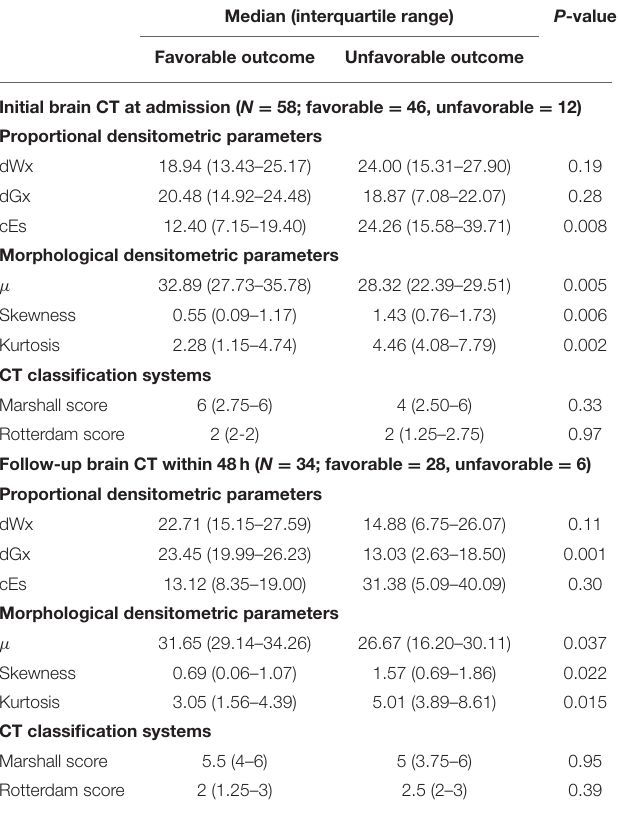
TABLE 2 | Comparison of densitometric parameters and conventional CT classification systems by outcome favorability based on the initial and follow-up brain